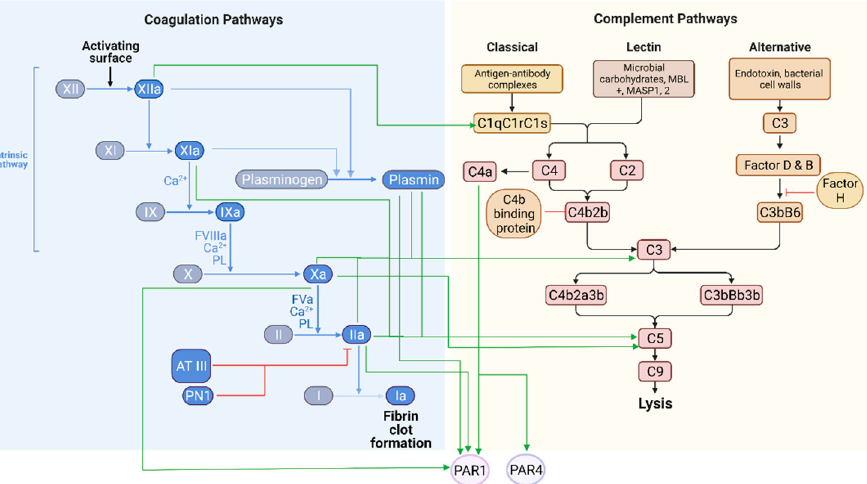
Figure 1. Crosstalk between complement and coagulation: the connections between the coagulation and complement cascades. Complement can increase tissue factor activity, thus activating the extrinsic coagulation pathway and forming activated thrombin. Coagulation can induce the activity of complement factors as well. Thrombin, human FIXa, FXa, and FXIa, and plasmin were all found to cleave C3 and C5, and thrombin can initiate the activation of C5a in the absence of C3 in- vivo and ex- vivo . C4a was found to be an endogenous ligand for PAR1 and PAR4 in human endothelial cells. Antithrombin III (AT III); Protease nexin 1 (PN1); Protease-activated receptor (PAR); Platelet membrane phospholipid (PL); Mannose-binding lectin (MBL); MBL associated serine proteases (MASP). Green arrows indicate activation whereas red lines indicate inhibition. Illustration created with BioRender.com. Accessed date: 16 December 2021.